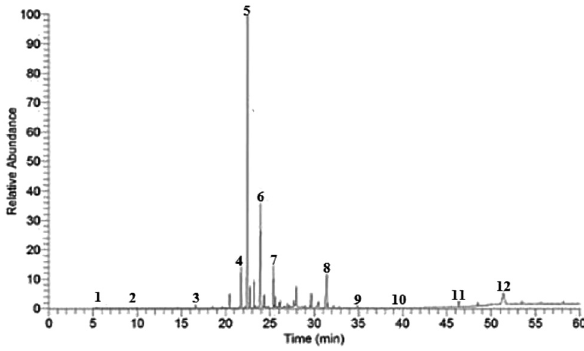
Figure 1: Chromatogram of volatile compounds pro fi led by GC - MS.